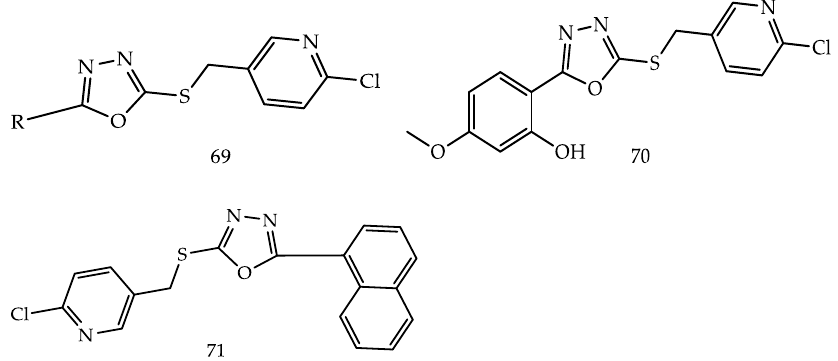
Figure 15. The chemical structure of 2-chloropyridine derivatives possessing 1,3,4-oxadiazole moi- ety .